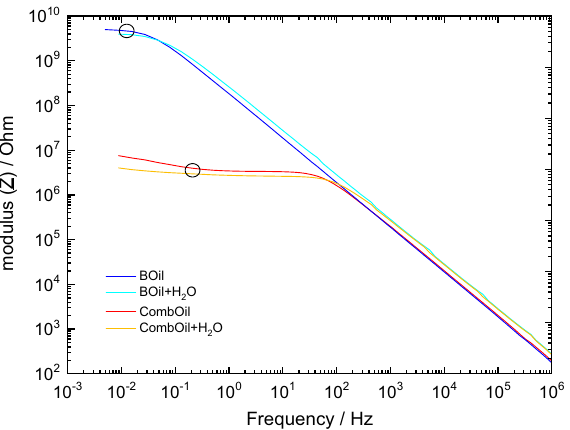
Figure 7. Electrochemical impedance spectra for BOil, BOil + H 2 O, CombOil and CombOil + H 2 O at room